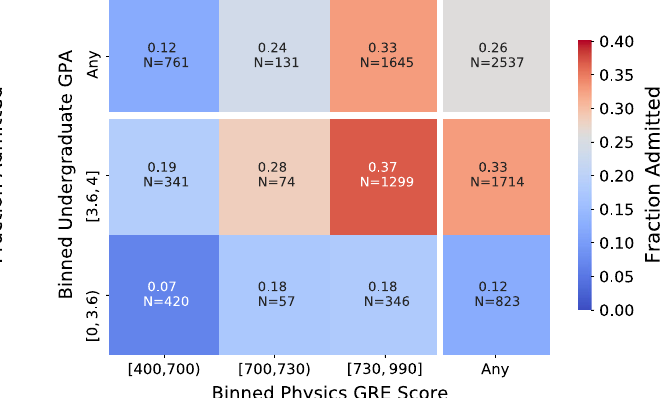
FIG. 16. A revised version of Fig. 4 showing the fraction of applicants admitted by undergraduate GPA and physics GRE score when the cutoff score for a high undergraduate GPA is